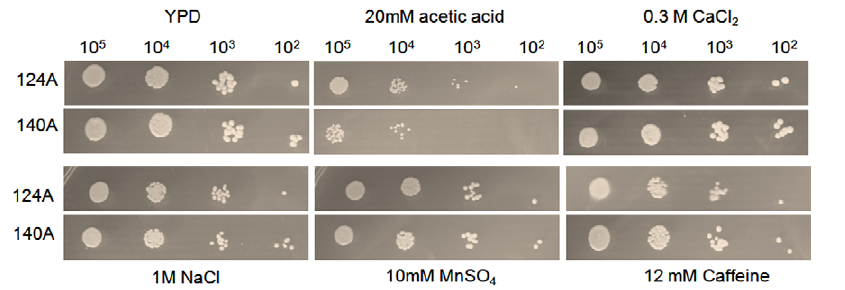
Figure 8. Invitro susceptibility assay. Growth of 124A and 140A yeast cells at 37 u C for 48 h on YPD and YPD containing 20mM acetic acid, 0.3M CaCl 2 , 1M NaCl, 10mM MnSO 4 , and 12mM caffeine. Drop tests were performed by spotting 10 m l of 10 5 , to 10 2 cells/ml dilutions.